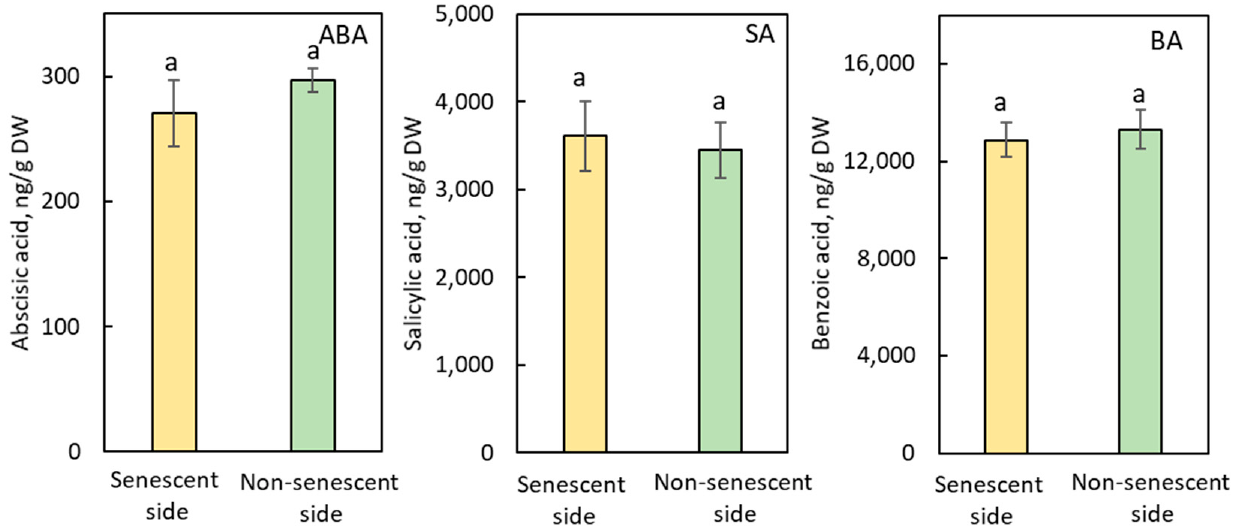
Figure 4. Endogenous levels of abscisic acid (ABA), salicylic acid (SA), and benzoic acid (BA) in the senescent and non-senescent sides of the SAZ induced by JA-Me in the internode explants of Bryophylum calycinum . Values are the mean with standard error (n = 6). Different letters on the column (a, b) indicated statistically significant at p < 0.05 after ANOVA.